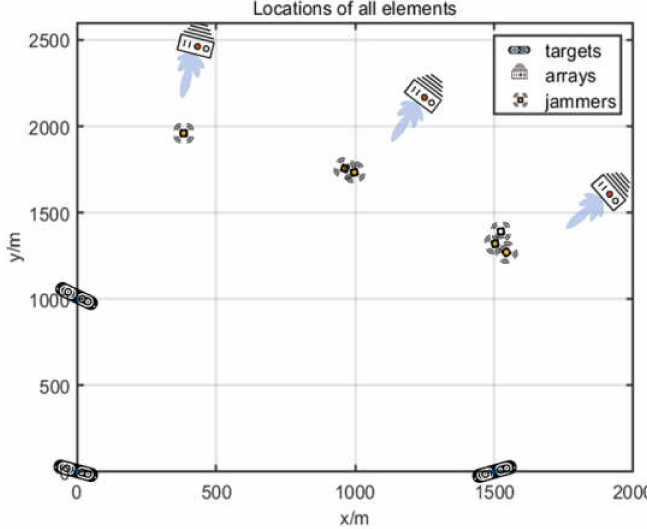
Figure 6. Locations of the elements in the model of a multitarget scene.